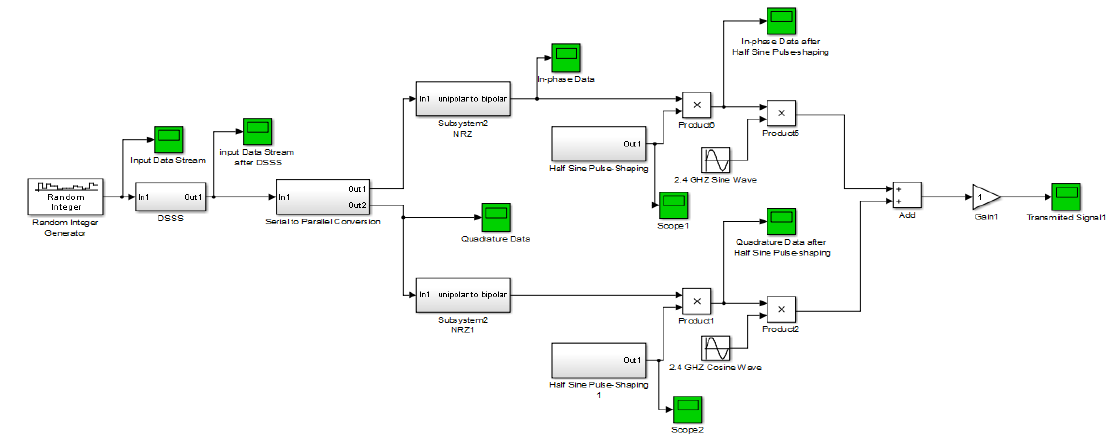
Fig. 10. Zigbee Transmitter with OQPSK Modulation and Half Sine Pulse-shaping.